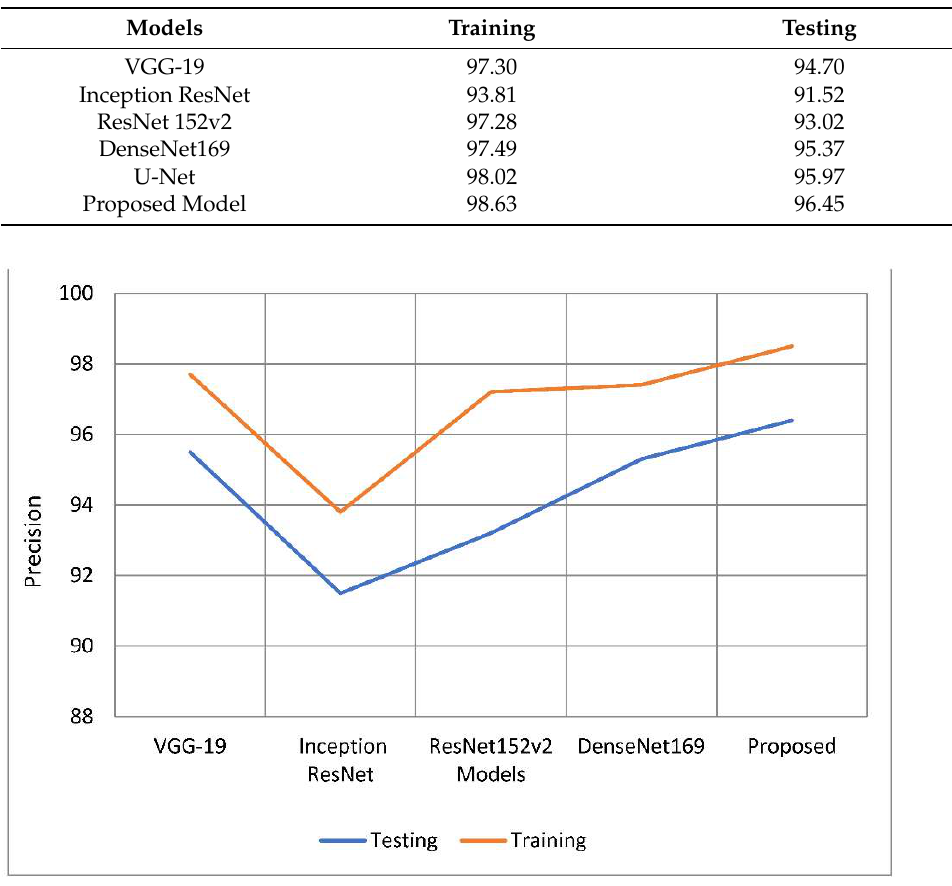
Figure 9. A comparative analysis of precision of the proposed model with traditional models.